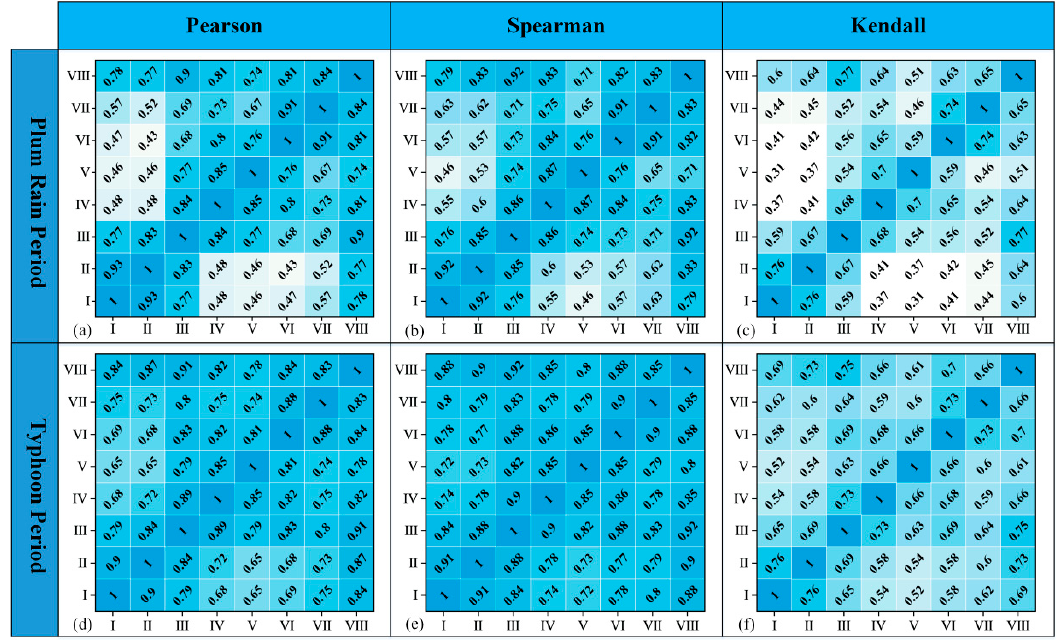
Figure 4. Correlation results of precipitation between eight hydrological regions. ( a – c ) are the results for the plum rain period. ( d – f ) are the results for the typhoon period; ( a , d ) are Pearson correlation results; ( b , e ) are Spearman correlation results; ( c , f ) are Kendall correlation results.